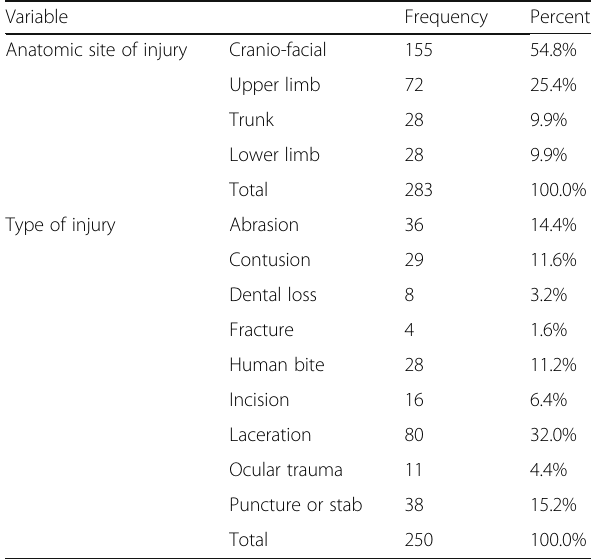
Table 5 The site and type of injury in the studied victims of non-fatal interpersonal violence